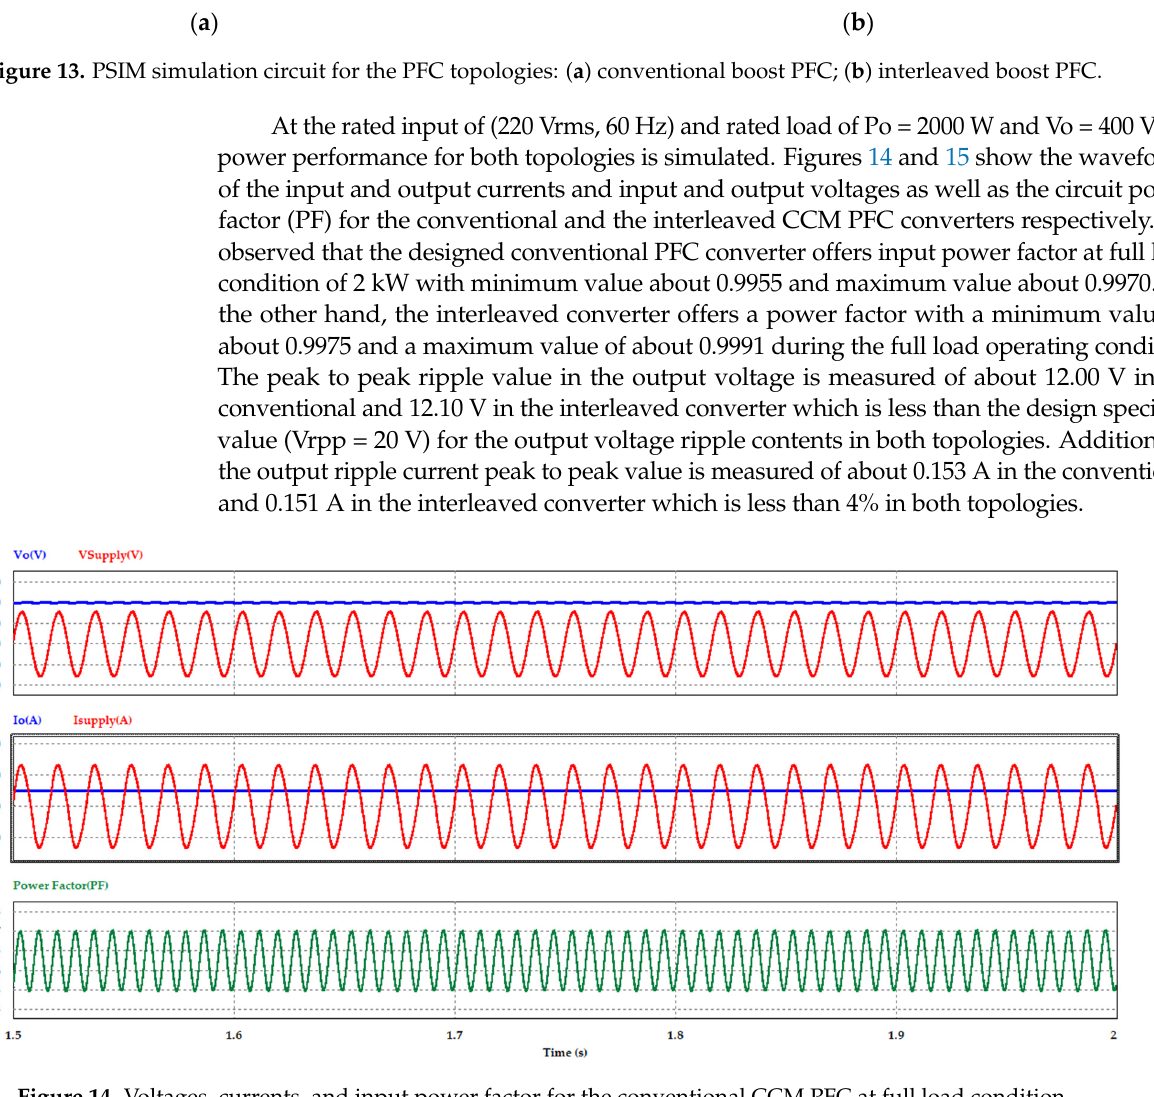
Figure 14. Voltages, currents, and input power factor for the conventional CCM PFC at full load condition.